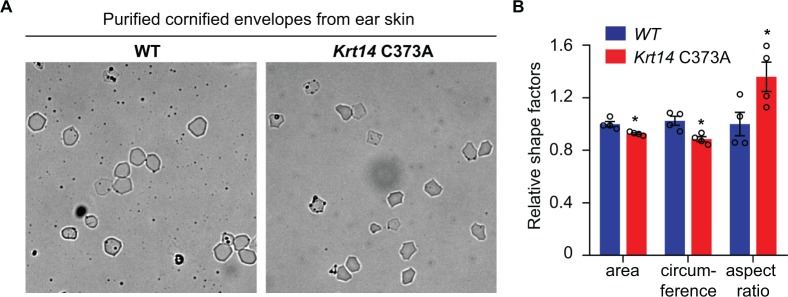
Analysis of purified cornified envelopes from ear skin.(A) Representative microscopic images of cornified envelopes isolated (CE) from WT and Krt14 C373A ear skin. Bar, 100 µm. (B) Quantitation of surface area, circumference, and aspect ratio of CEs. N = 4. Approximately 100 CE pieces were measured per mouse. Data represent mean ± SEM. Student’s t test: *p<0.05, n.s., no statistical difference.